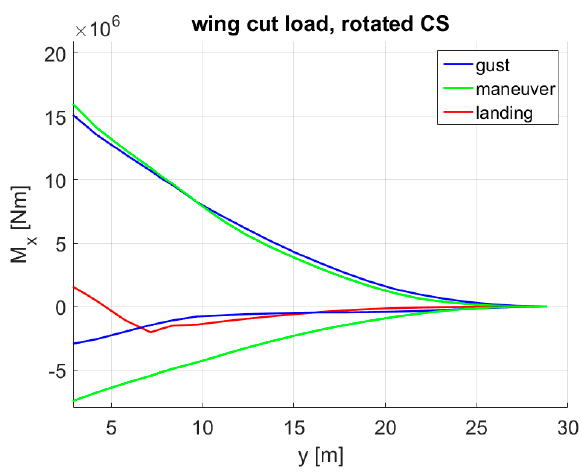
Figure 26. Bending moment envelope with MLA + GLA.